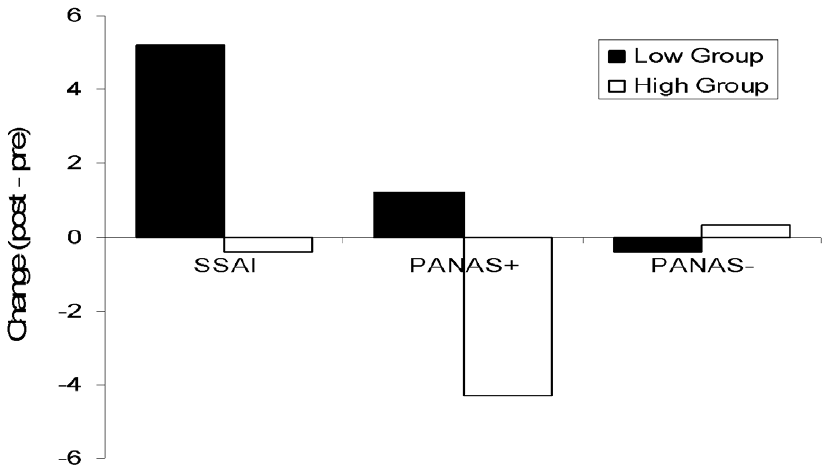
Figure 1. Shows the change between post- and pre-internet use in state anxiety (SSAI), positive mood (PANAS + ), and negative mood (PANAS-) for both the low internet-using (Low) and high internet-using (High)